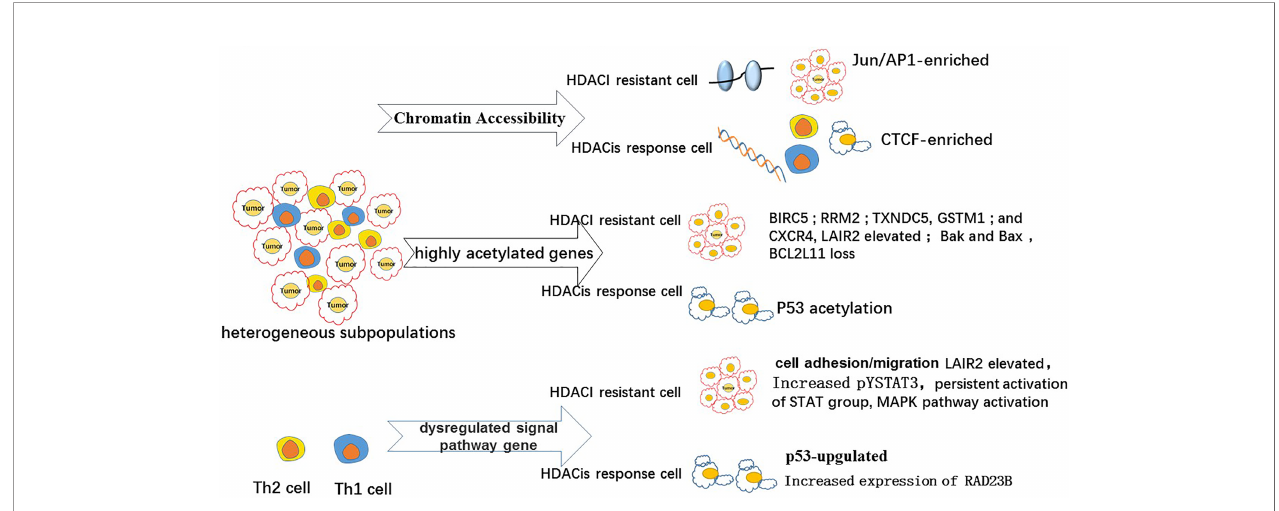
FIGURE 2 | Mechanism of HDACI therapy for drug